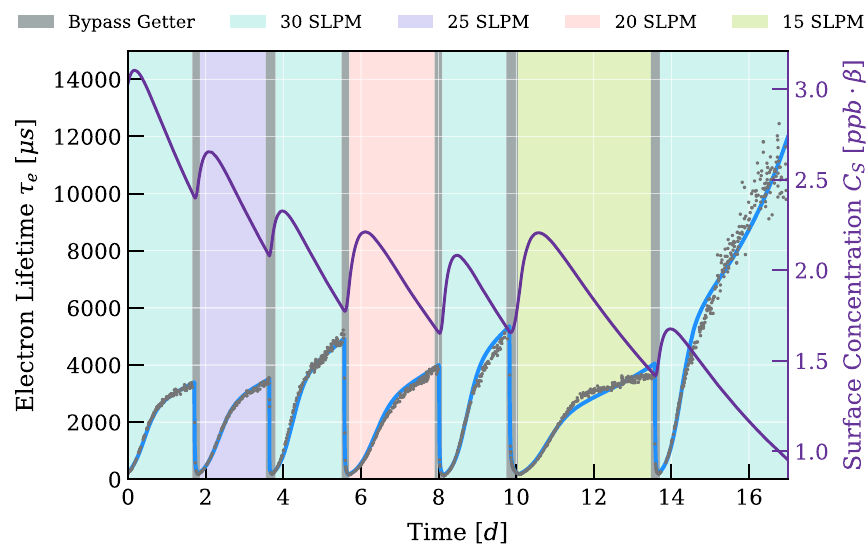
When x ( t = 0 ) is high, the second term on the right hand side of Eq. (4) dominates, giving x ( t ) ≈ x ( 0 ) · e − t /τ C (for f = ε = 1). After some time t (cid:5) τ C , however, the rate of O 2 removal becomes comparable to the sources of new O 2 and x becomes flat